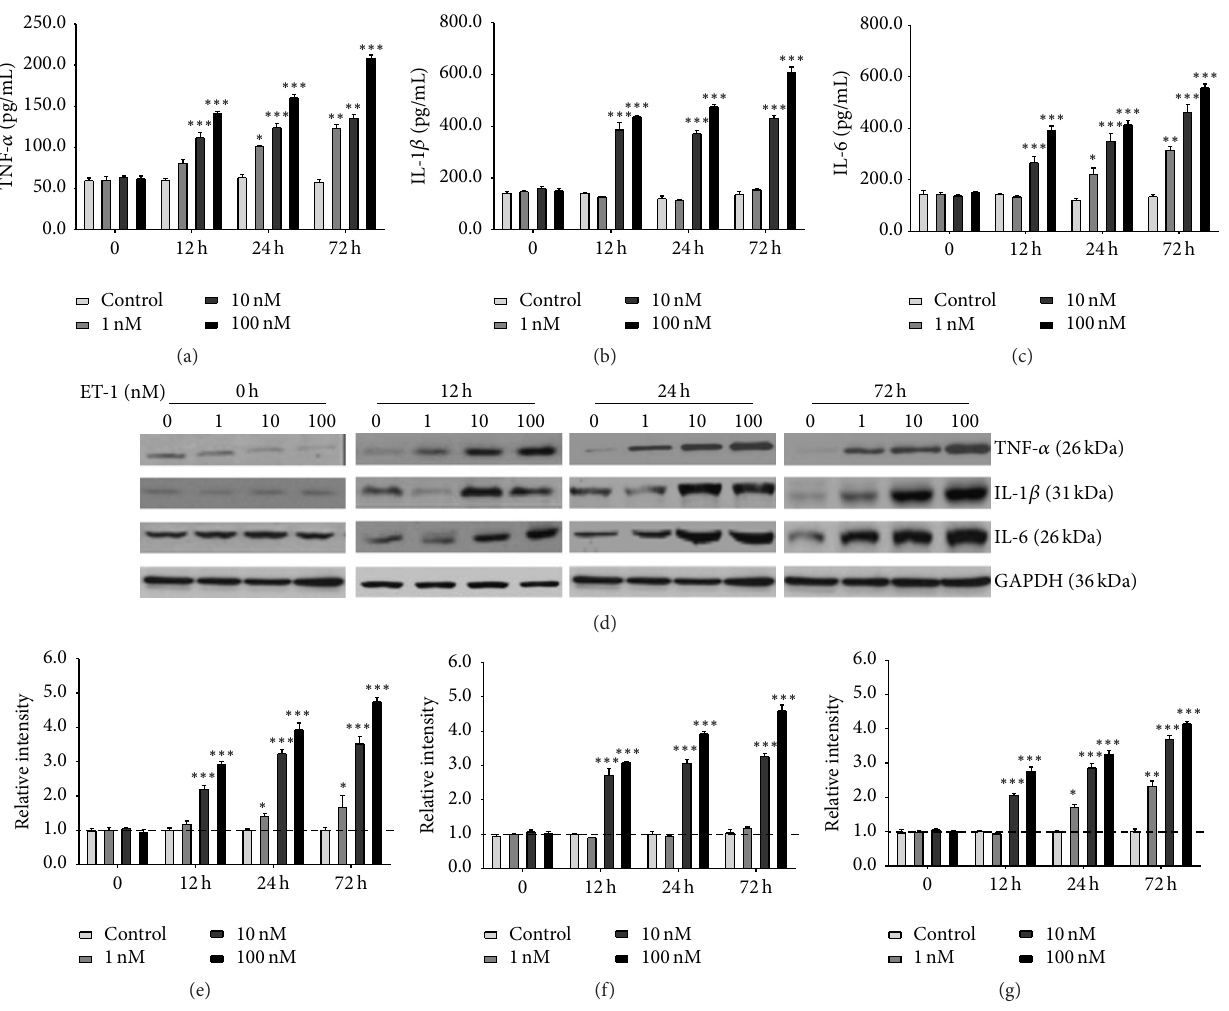
Figure 3: ET-1 increased secretion of TNF- 𝛼 , IL-1 𝛽 , and IL-6 in dose- and time-dependent manner. TNF- 𝛼 (a), IL-1 𝛽 (b), and IL-6 (c) expression were measured by ELISA. The effects of ET-1 on protein expression of TNF- 𝛼 ((d), (e)), IL-1 𝛽 ((d), (f)), and IL-6 ((d), (g)) in PDLSCs were measured by Western Blotting. In agreement with the ELISA results, ET-1 induced TNF- 𝛼 , IL-1 𝛽 , and IL-6 in a dose-dependent and time-dependent manner. The stimulatory effects on protein expression reached a peak at 72 hours after stimulation. Each bar represents the mean ± standard deviation ( 𝑛 = 3 ). ∗ 𝑃 < 0.05 ; ∗∗ 𝑃 < 0.01 ; ∗∗∗ 𝑃 < 0.001